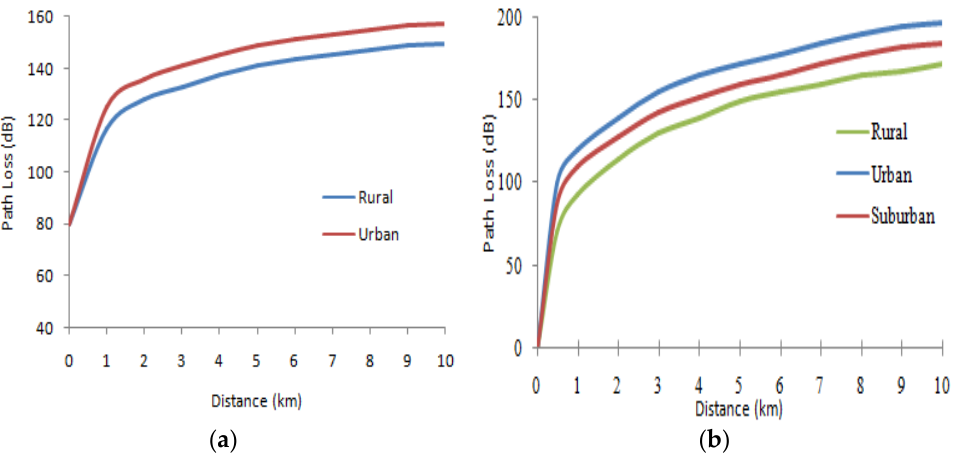
Figure 1. Influence of distance and type of medium on propagation: ( a ) Cost 231 Hata model; ( b ) Okumura—Hata model.